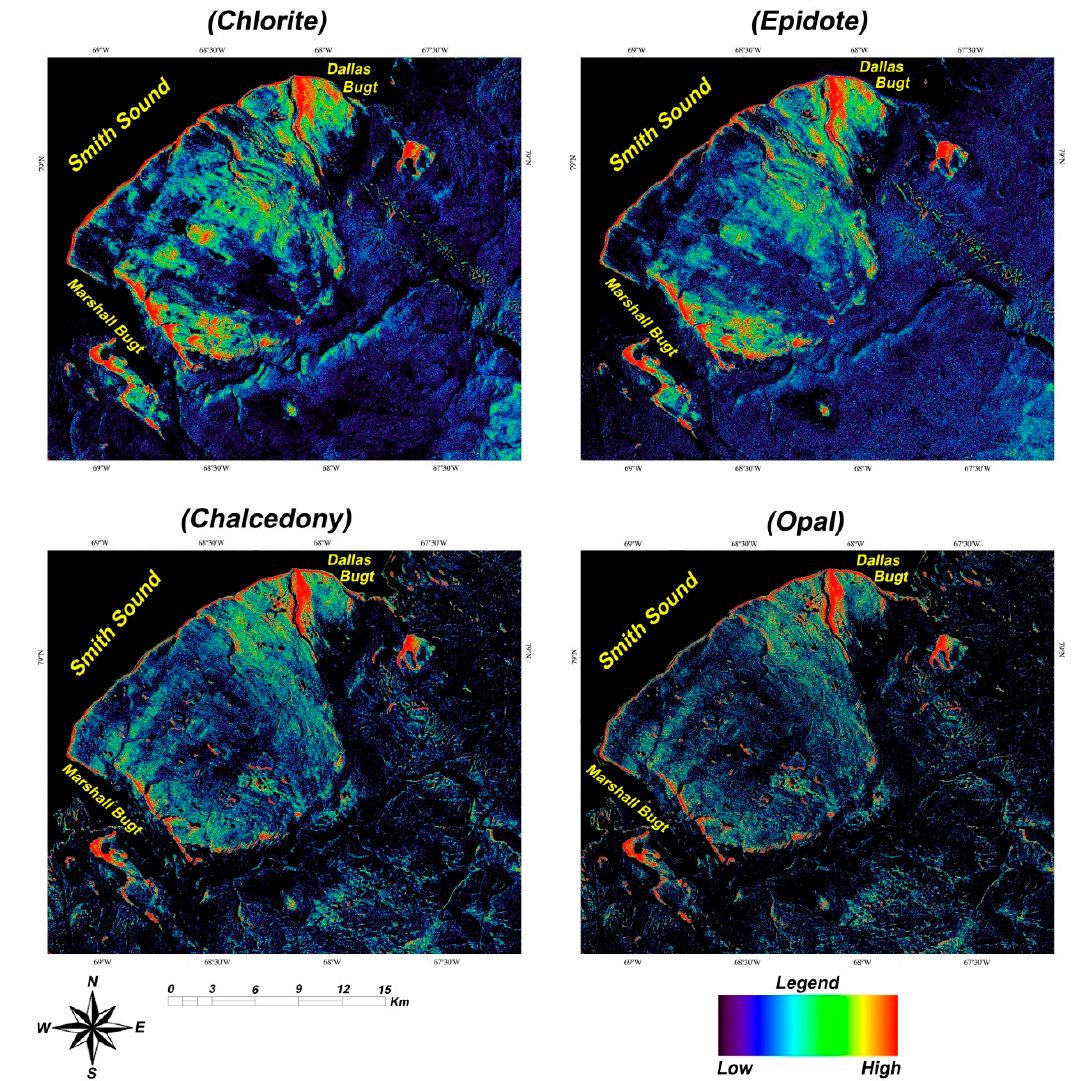
Figure 12. Fraction images of the selected end-member minerals derived from the adaptive coherence estimator (ACE) algorithm for the selected spatial subset covering the Cu-Au mineralization belt and surrounding areas. Pseudo-color ramp was applied to greyscale rule images.